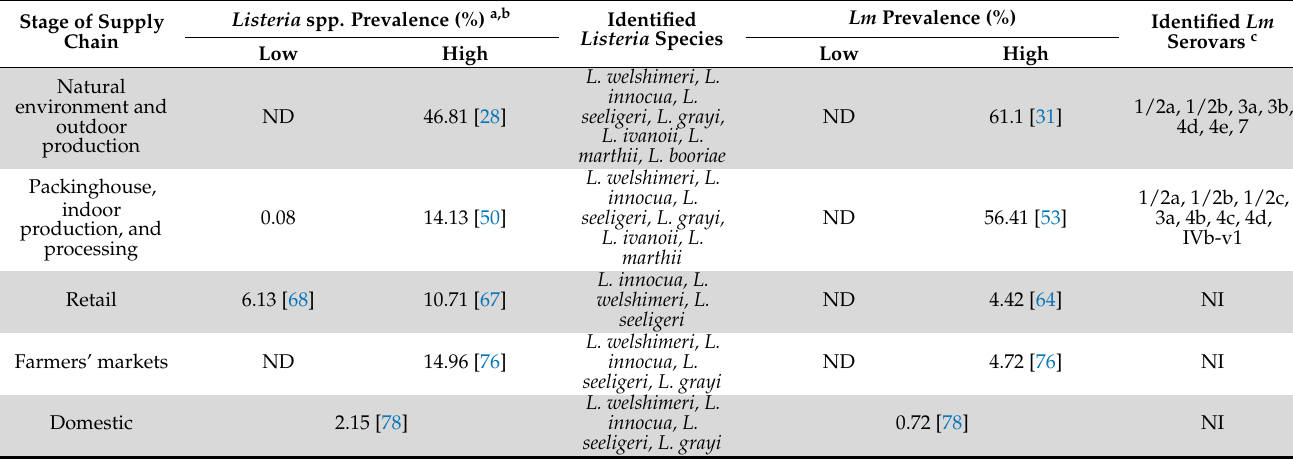
Table 3. Range of Listeria spp. and Lm prevalence and identified Listeria spp. and Lm serovars by supply chain stage. Stage of Supply